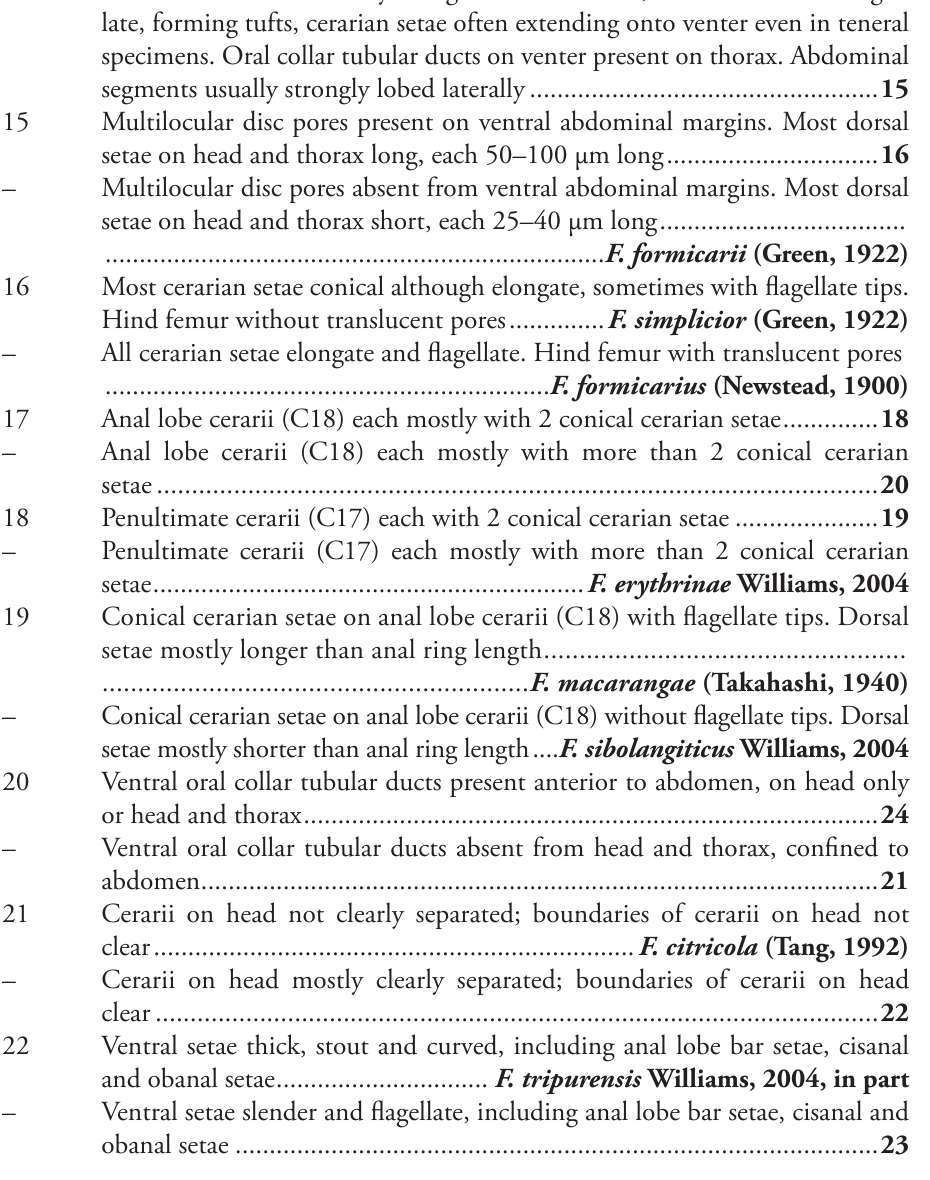
– Either all cerarii with many long, conical, or flagellate setae forming tufts, or some cerarii on head and thorax containing paired flagellate setae ............. 14 14 Abdominal cerarii with short and conical setae only. Cerarii on head and thorax with long paired flagellate setae. Oral collar tubular ducts on venter absent from thorax. Abdominal segments not strongly lobed laterally ........... – All cerarii each with many elongate cerarian setae, either conical or flagel- late, forming tufts, cerarian setae often extending onto venter even in teneral specimens. Oral collar tubular ducts on venter present on thorax. Abdominal 15 Multilocular disc pores present on ventral abdominal margins. Most dorsal setae on head and thorax long, each 50–100 µm long ............................... 16 – Multilocular disc pores absent from ventral abdominal margins. Most dorsal